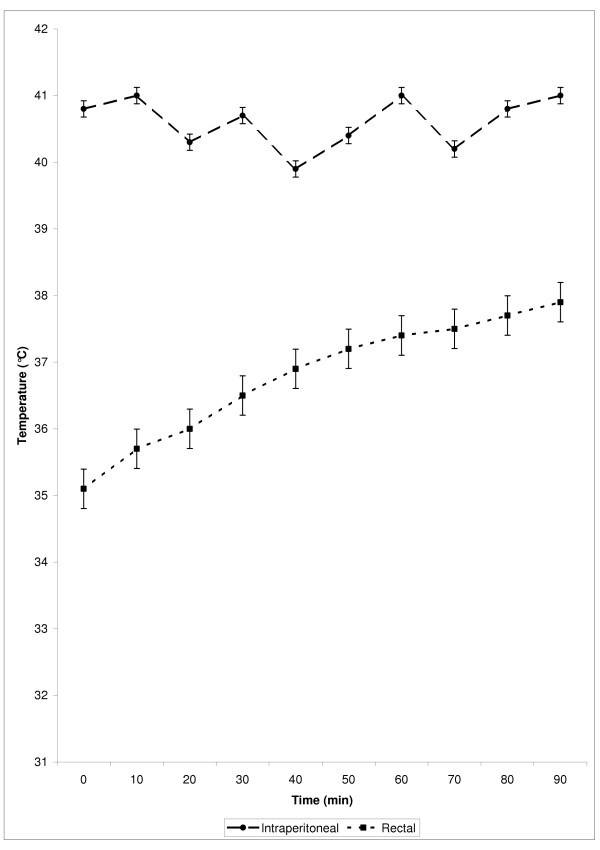
The temperature course during HIPEC in the abdomen and in the rectal cavity.